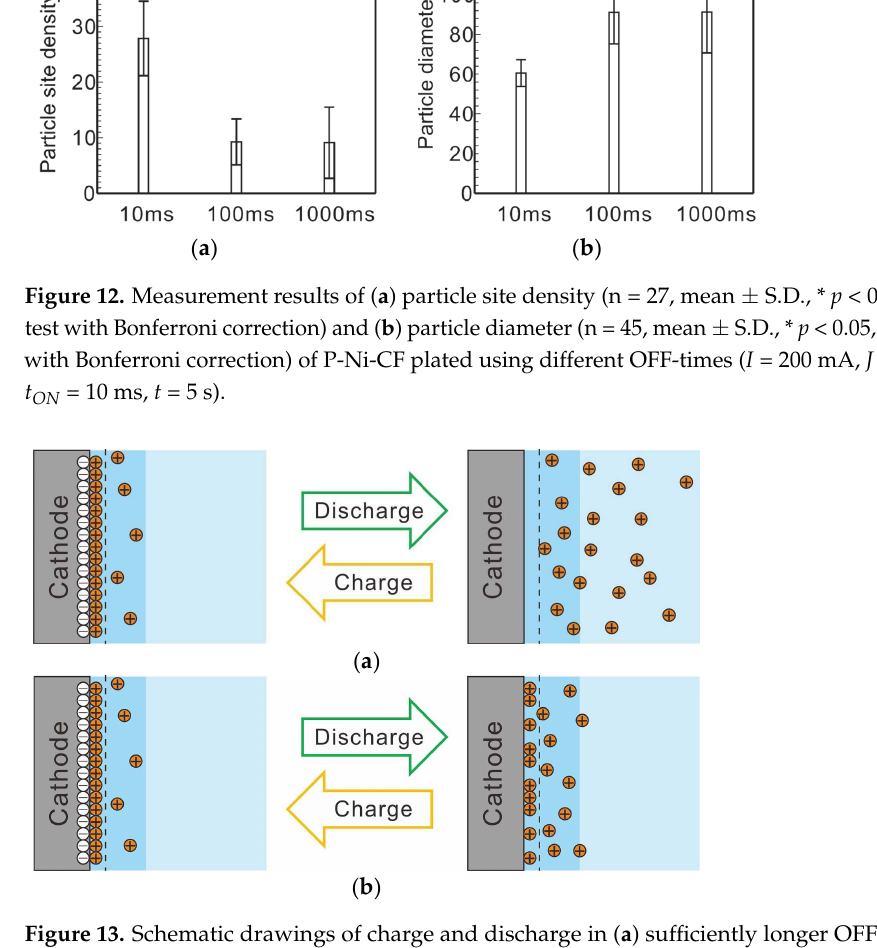
Figure 13. Schematic drawings of charge and discharge in ( a ) sufficiently longer OFF-time and ( b ) shorter OFF-time.